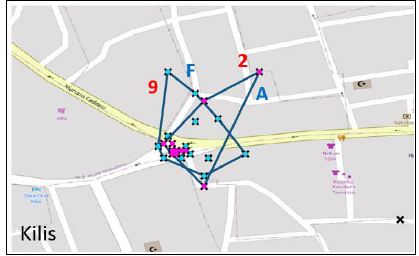
Figure 9. Mersin Region Repeatedly-detected Clusters in Different Periods (2016-2017, 2018-2019)